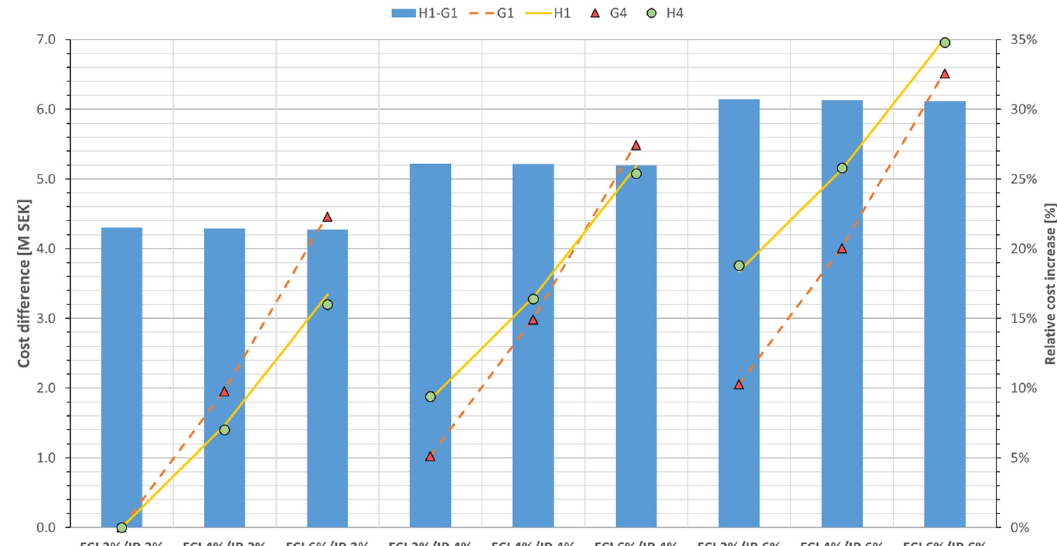
Figure 12. Boundary conditions—Cost difference [M SEK] between reference concepts G1 and H1, as well as relative increase [%] in total costs for variants G1, G4, H1, and H4, with changing fuel cost increase (FCI) and interest rate (IR). Relative values are calculated using FCI 2%/IR 2% as reference.